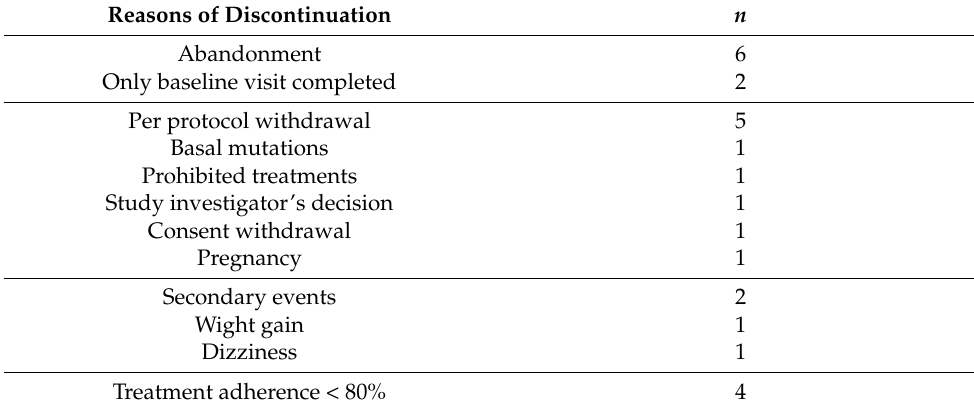
Table 1. Reasons for discontinuation before week